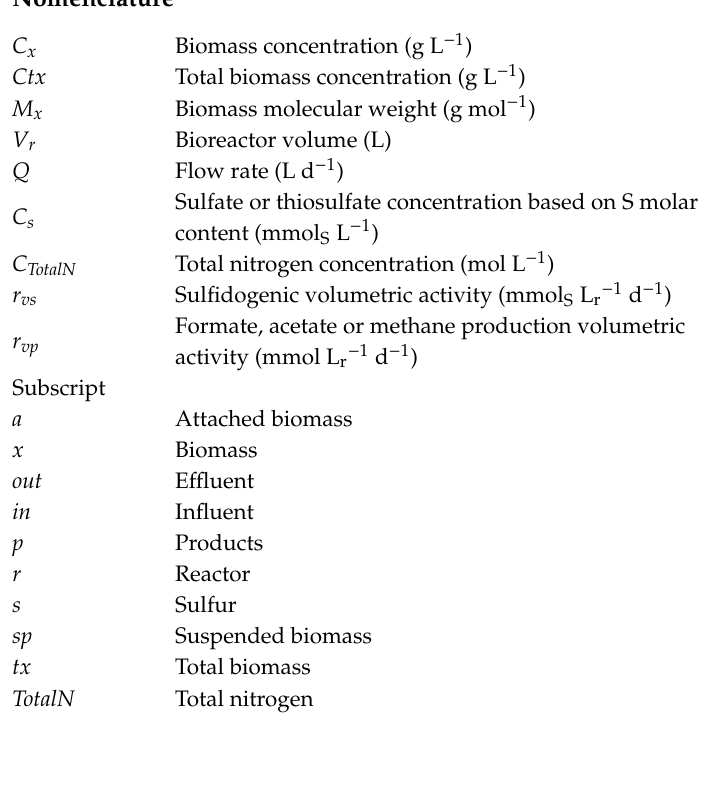
Figure S1. Scheme of the gas-lift bioreactor set-up, Figure S2. Microscopic observations of the biomass from the